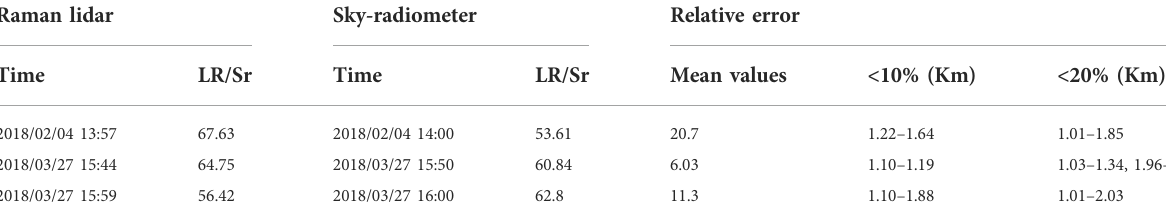
TABLE 3 The average lidar ratios and relative errors inverted using two detection methods. Raman